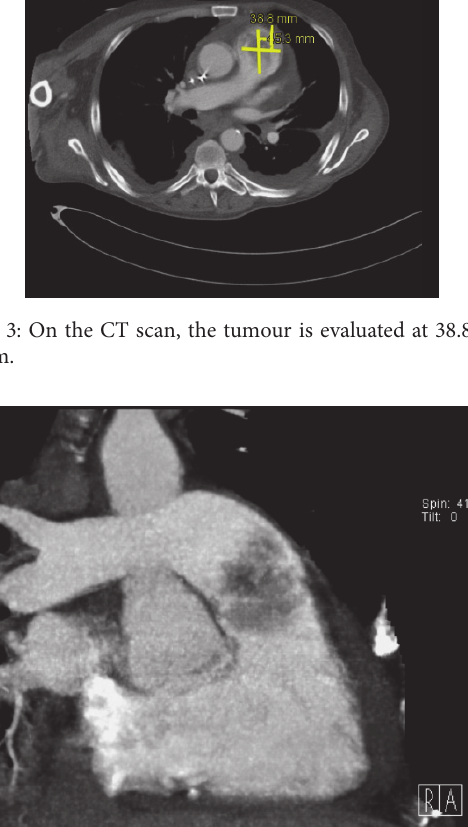
Figure 4: Illustration of the tumour’s heterogeneity in contrast